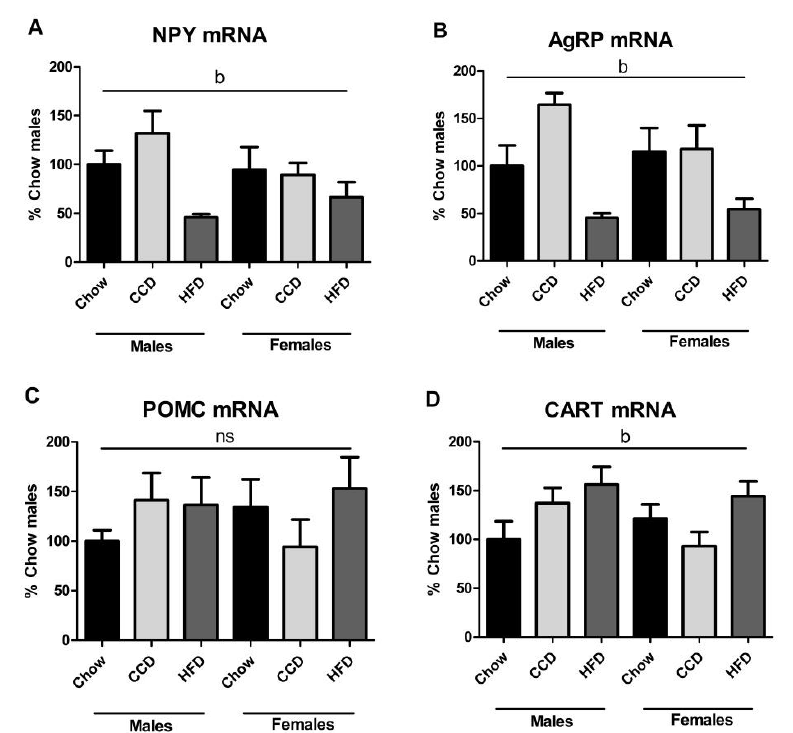
Figure 6. Relative mRNA levels of orexigenic and anorexigenic neuropeptides in the hypothalamus: Neuropeptide Y (NPY; A ), Agouti-related protein (AgRP; B ), proopiomelanocortin (POMC; C ) and cocaine and amphetamine regulated transcript (CART; D ). b: effect of diet, ns = non-significant. HFD = high-fat diet; CCD = commercial control diet, n = 6.